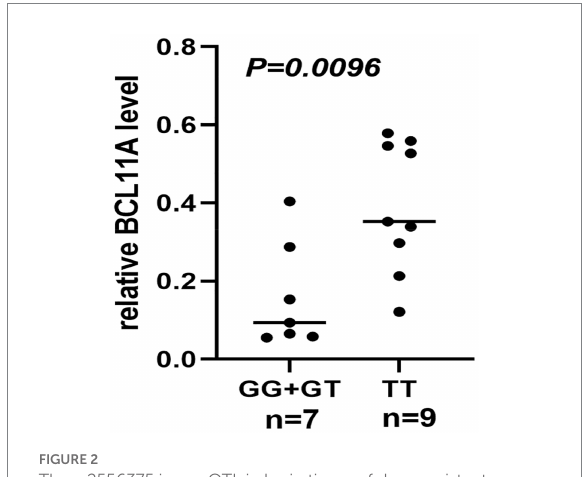
FIGURE 2 The rs2556375 is an eQTL in brain tissue of drug-resistant epilepsy patients. The carriers of the G allele exhibited downregulated BCL11A gene expression.